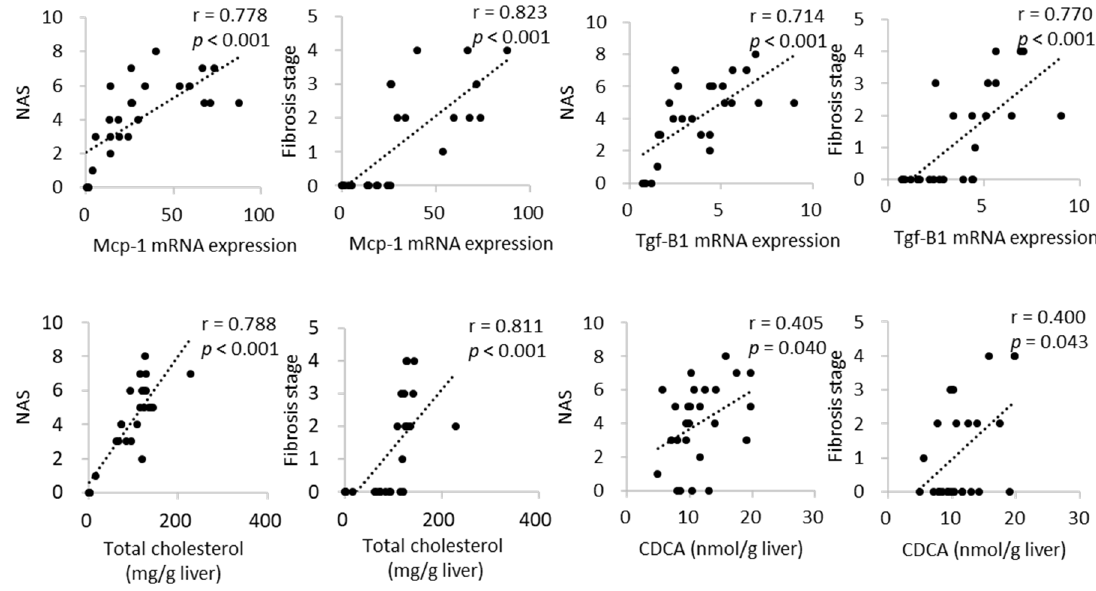
Figure 4. Correlation between histopathological assessment and mRNA expression and content of cholesterol and CDCA in the liver. CDCA, chenodeoxycholic acid; NAS, nonalcoholic fatty liver disease activity score; Mcp-1, monocyte chemotactic protein-1; Tgf- β 1, profibrotic marker transforming growth factor- β 1.